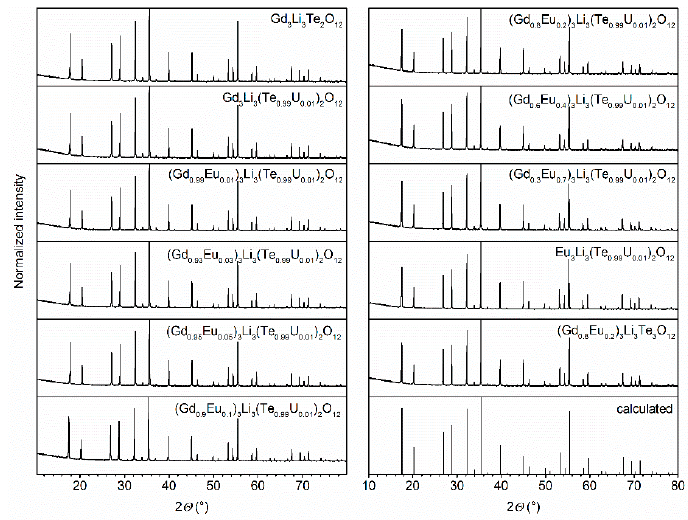
Figure 4. Powder XRD patterns of Gd 3 Li 3 Te 2 O 12 , Gd 3 Li 3 (Te 0.99 U 0.01 ) 2 O 12 , (Gd 0.8 Eu 0.2 ) 3 Li 3 Te 2 O 12 , and (Gd 1 − x Eu x ) 3 Li 3 (Te 0.99 U 0.01 ) 2 O 12 with x = 0…1, as well as calculated reference pattern for Cu K α radiation.